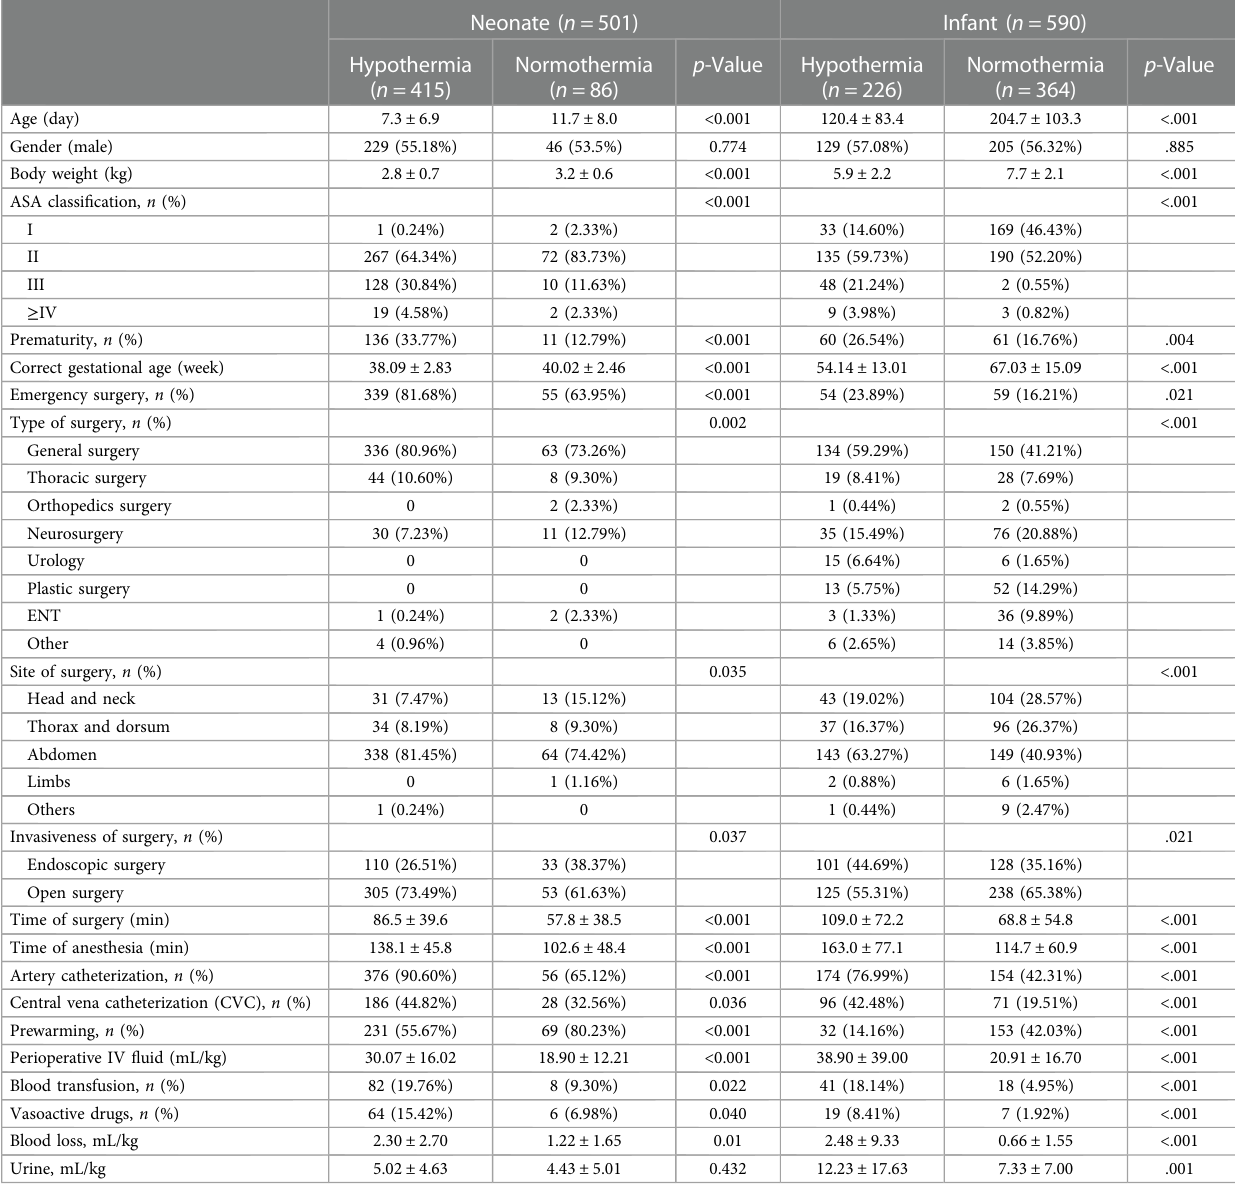
TABLE 3 Basic characteristics and univariate analysis results of hypothermia in neonates and